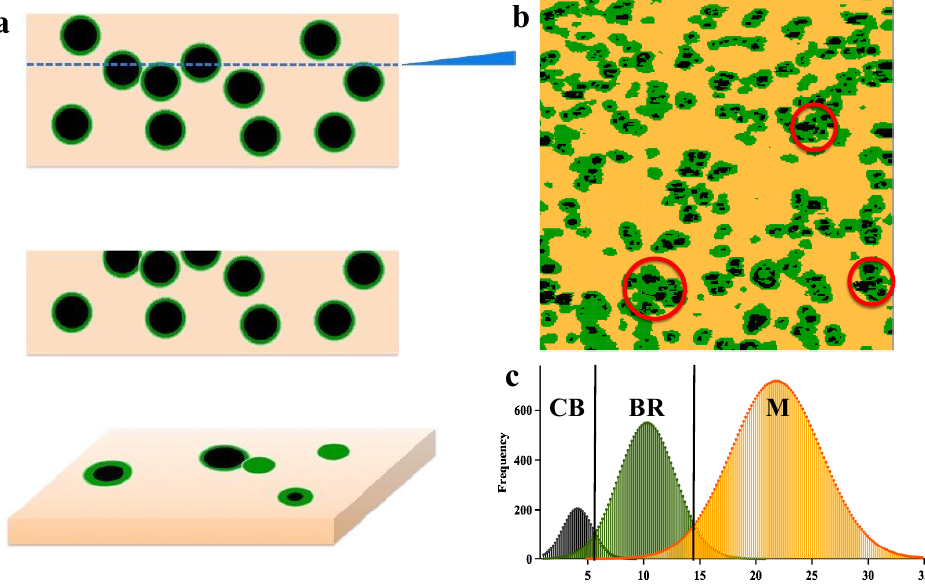
Figure 3. ( a ) Schematic for CB/IR before cutting and after cutting. ( b ) Visualization of the dispersion structure of carbon black in IR by AFM adhesion force images, where the black area is CB, the yellow area is IR rubber, and the green area is the interface. ( c ) Histograms of adhesion force mapping for CB, IR and the interface.